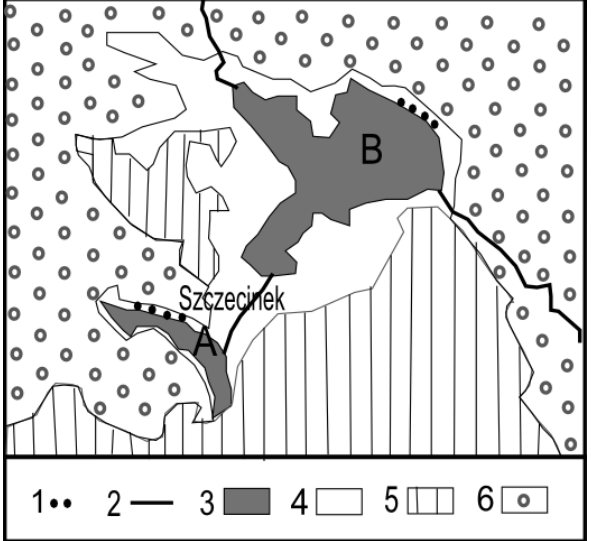
Fig. 1. The geomorphology of the study area: A – Lake Trzesiecko, B – Lake Wielimie 1 – beach, 2 – river, 3 – lake, 4 – kettles, 5 – morainic plateau of the Pomeranian Phase, 6 – outwash (based on Maksiak & Mróz,